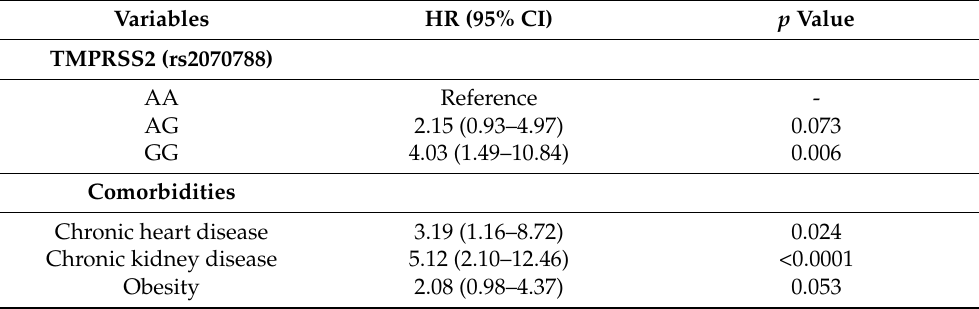
Table 3. Characteristics associated with the risk of death according to Cox’s proportional haz- ards